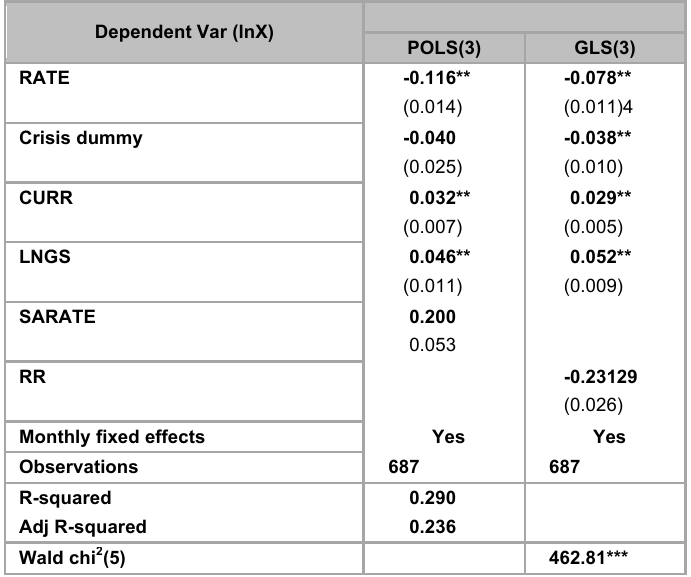
Estimation results with the inclusion of domestic credit